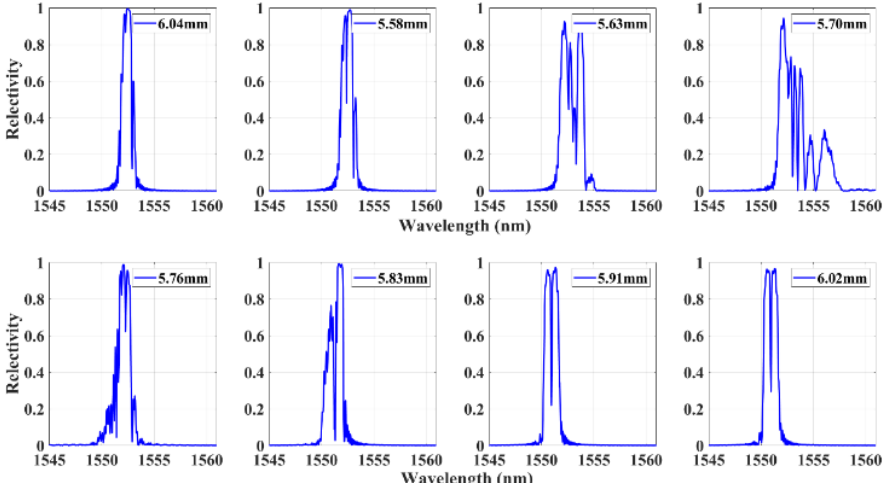
Figure 5. Simulation reflection spectra of FBG1 based on the modified strain distribution for different crack lengths.